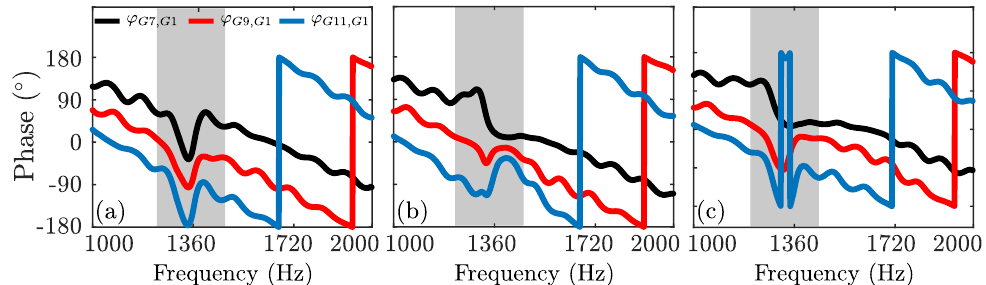
Figure 14. Phase of the pressure signals from microphone G7,G9 and G11 compared with G1 for different resonator configurations. ( a ) Single Resonator; ( b ) s / λ = 0.25; ( c ) s / λ = 0.5.